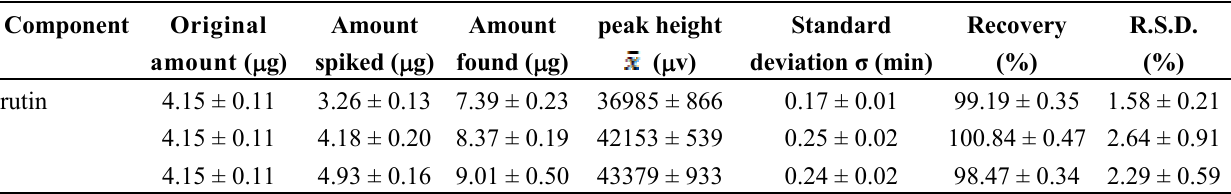
Table 2. Recovery test of the rutin from tobacco ( n = 3).